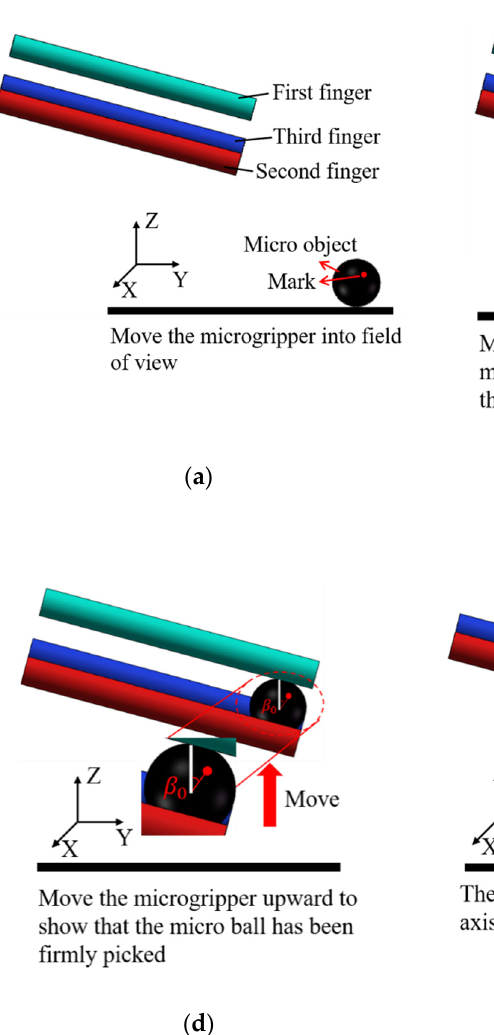
Figure 16. The schematic diagram of micro-objects manipulations. ( a ) Initial state; ( b ) Move the microgripper with the manual manipulator to approach the micro-object; ( c ) the micro-object is gripped; ( d ) Lift the micro-object; ( e ) Rotate the micro-object about an axis; ( f ) the micro-object is released.